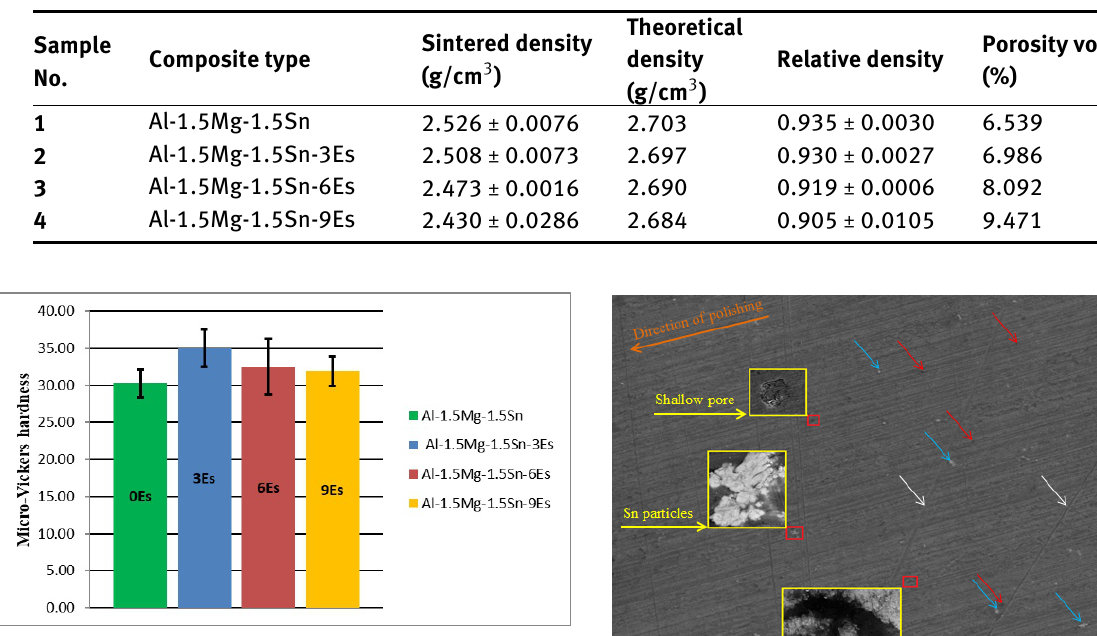
Table 2: Theoretical, experimental, and relative density and porosity volume percentage of all produced samples.